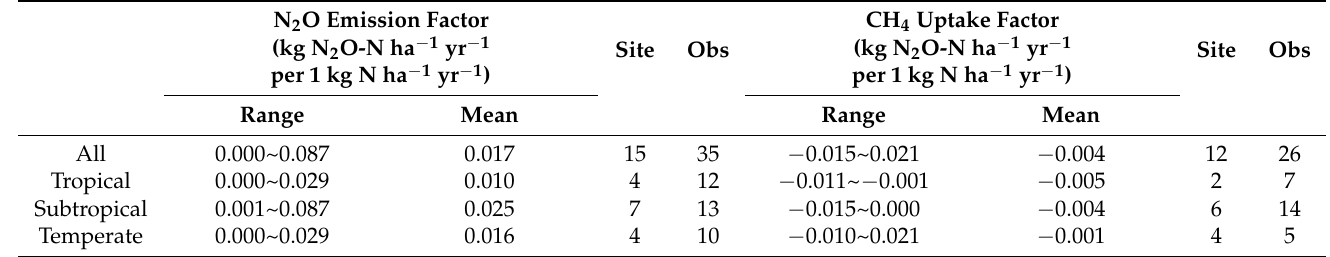
Table 2. N 2 O emission factor and CH 4 uptake factor relative to N addition from Chinese forests across different climatic